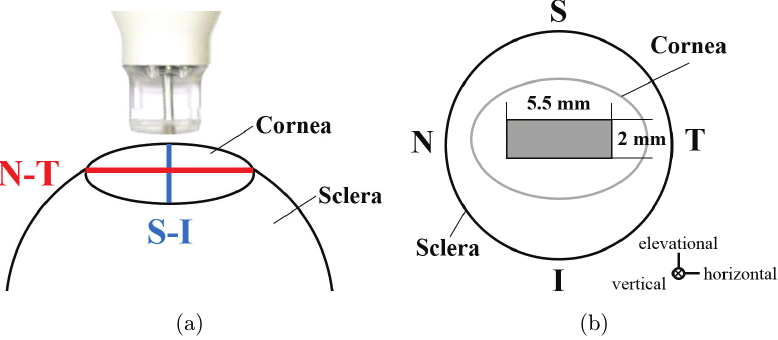
Fig. 1. Schematics of (a) ultrasound scanning orientations and (b) 3D scanning region. ( N : nasal, T : temporal, S : superior, I :